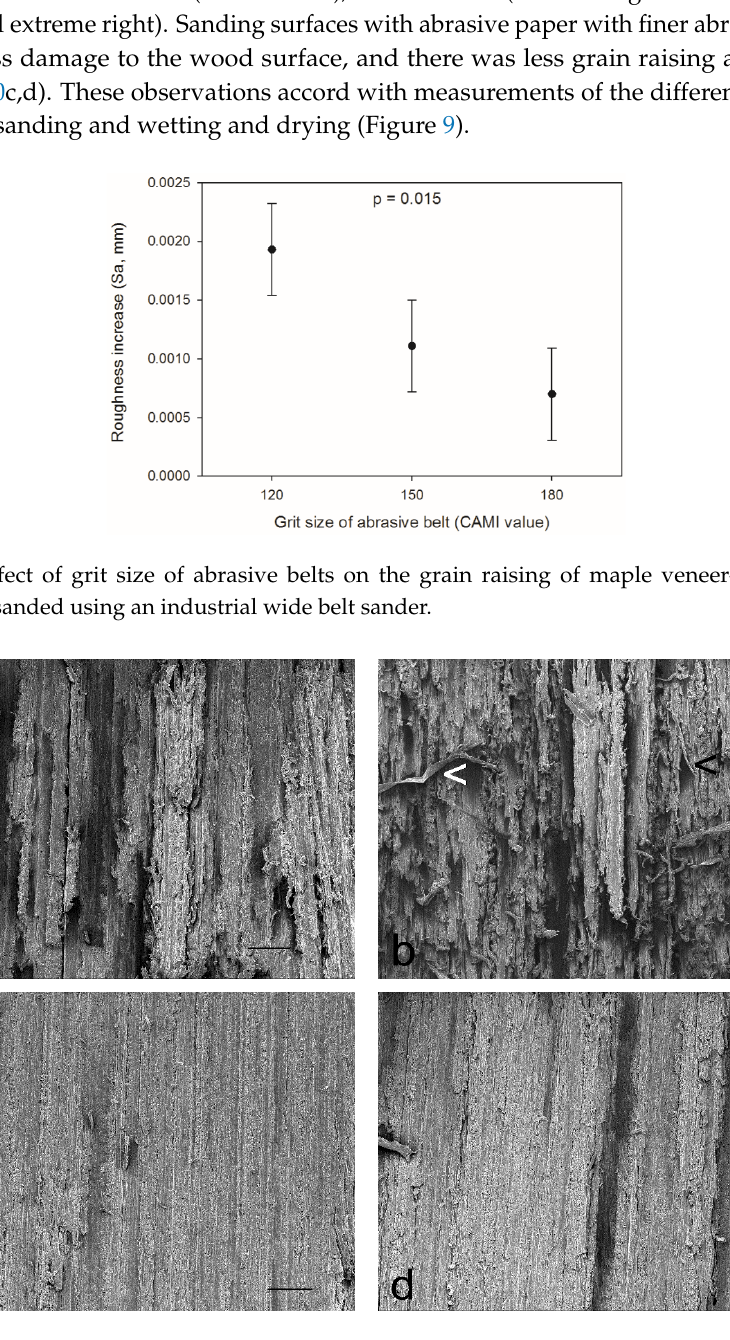
Figure 8. Tubular plastic wood model after a serrated tool was drawn across its surface.